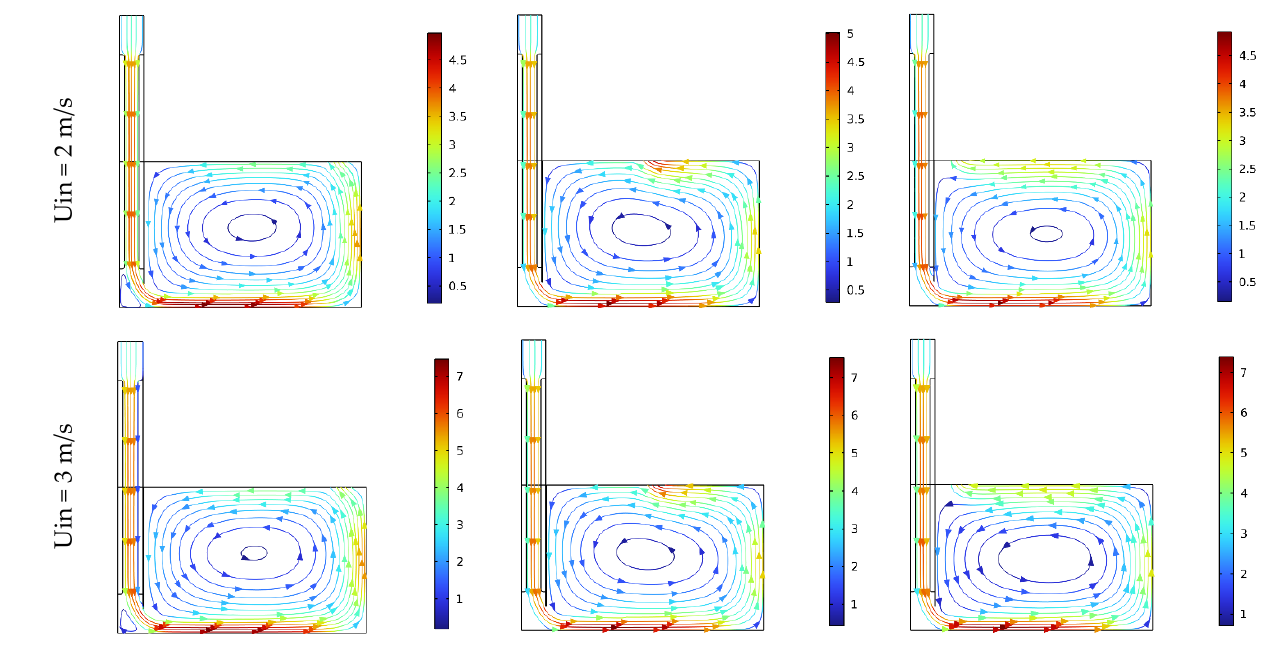
Figure 3. Effect of inlet velocity of the flow structure; T in = 45 °C, and t = 1000 s.